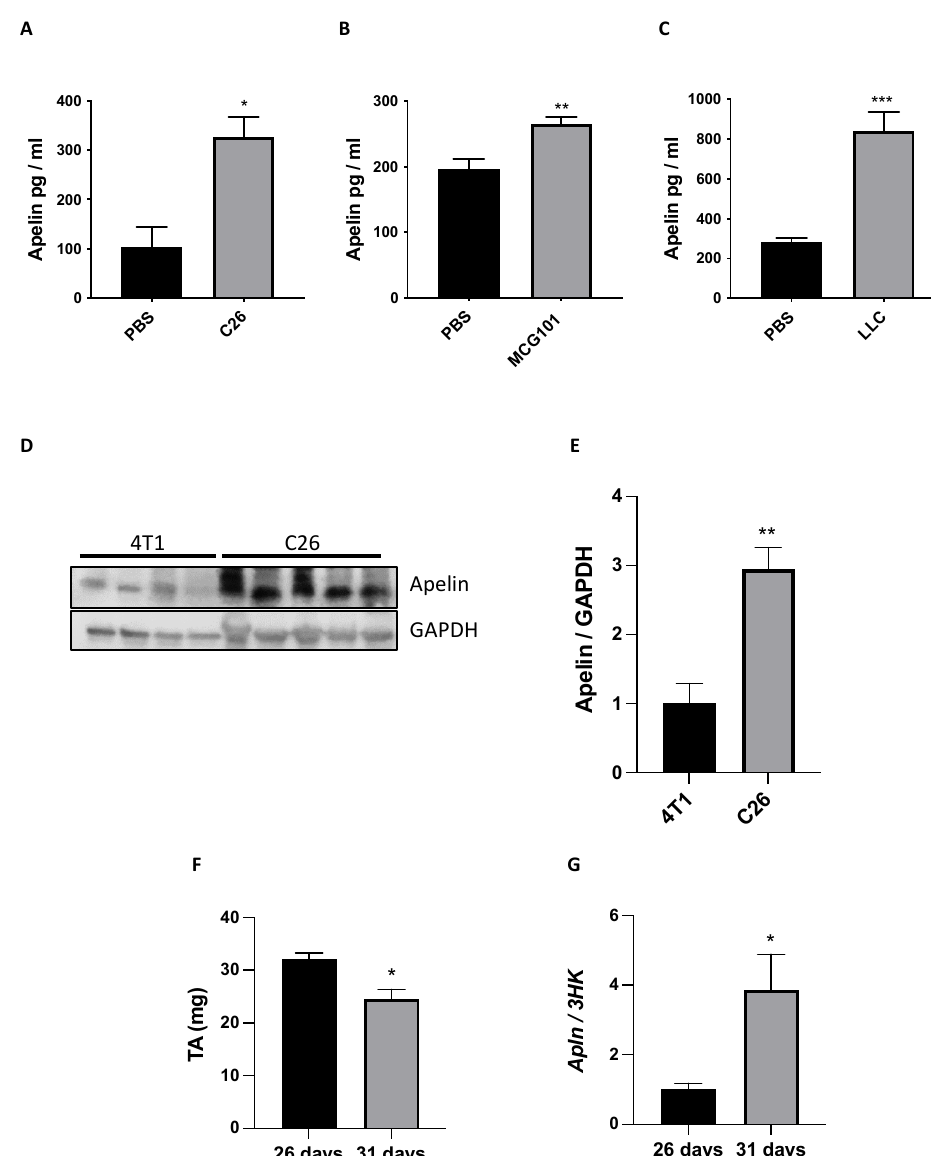
Figure 7. Plasma apelin is increased in cachectic cancer-bearing mice and it seems tumor-derived. ELISA was done on the plasma of mice with the cachectic tumors C26 ( A ), MCG101 ( B ) or LLC ( C ). Apelin was high in plasma of all three cancer types-bearing animals. Mann – Whitney test, * p ≤ 0.05, ** p ≤ 0.01, *** p ≤ 0.001. PBS, C26, n = 4–5; PBS, MCG101, n = 10–14; PBS, LLC, n = 6–10. Proteins from 4T1 or C26 tumors excised from mice were analyzed in Western blot for apelin and GAPDH as loading control ( D ). Quantitation for apelin/GAPDH is shown ( E ). Unpaired t -test, ** p ≤ 0.01, n = 4–5. TA weight of non-cachectic and cachectic pancreatic cancer bearing-mice is shown ( F ), Unpaired